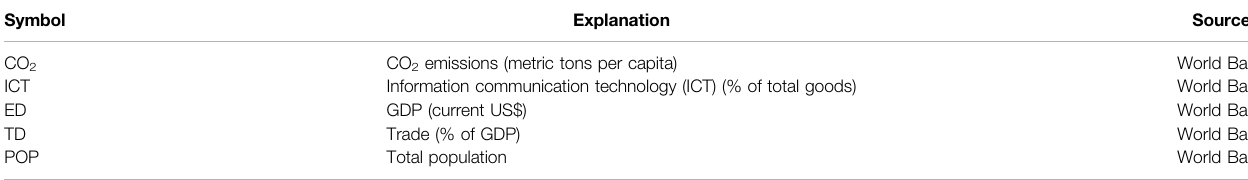
TABLE 1 | Variable description used in the model. Symbol